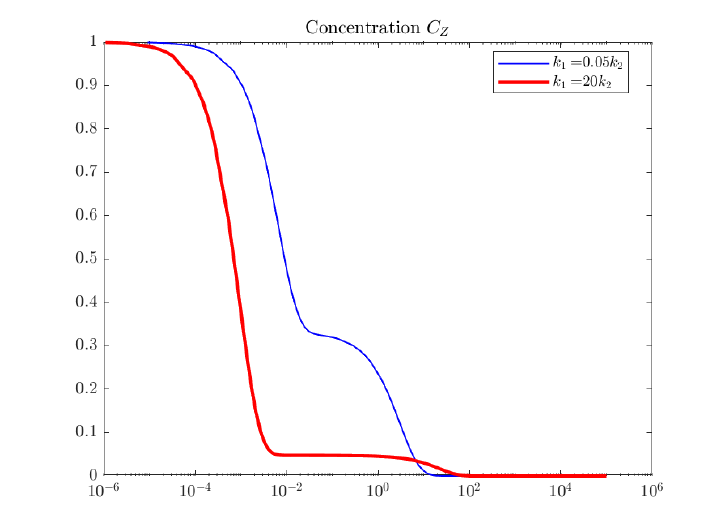
Figure 4. Concentration C Z for different k 1